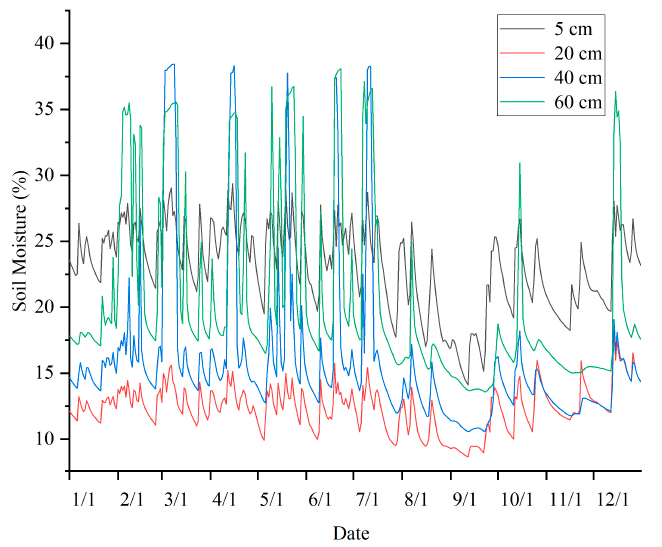
Figure 1. Map of soil moisture content at different depth change trends in a certain area.